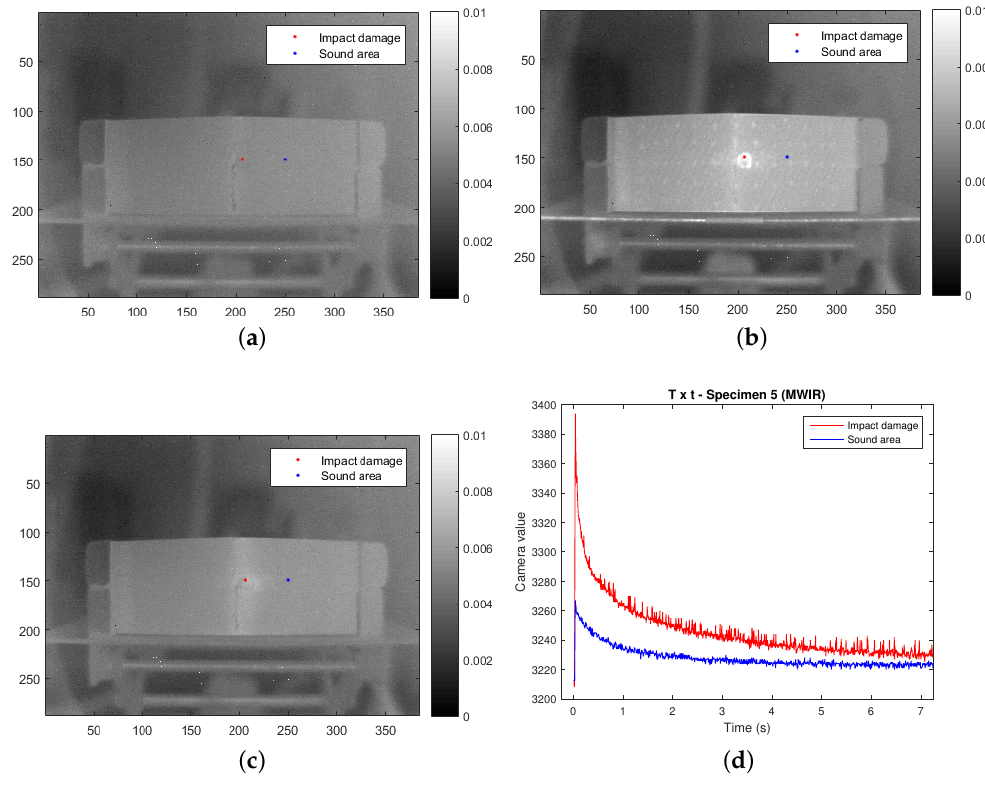
Figure 4. Raw MWIR data for specimen 5: ( a ) before flash pulse, ( b ) at 0.25s, ( c ) at 3s, and ( d ) temper- ature profiles of impacted (red) and sound (blue) regions (regions are also marked in the raw images). Hence, in order to apply the SVD to thermographic data, the 3D thermogram matrix representing time and spatial variations has to be reorganised as a 2D M × N matrix A .